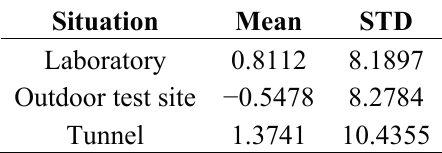
Table 1. The mean and standard deviation of the RSS fitting errors in different